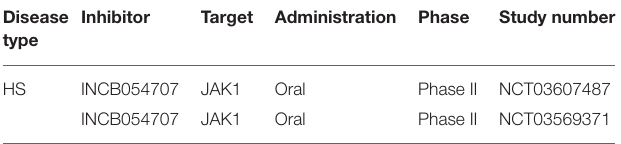
TABLE 6 | Trials on JAKI in hidradenitis suppurativa according to clinicaltrials.gov.